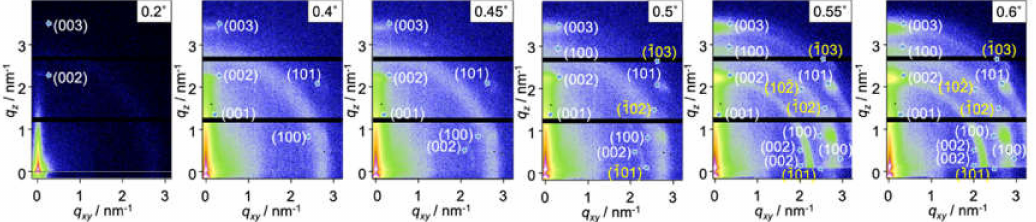
Figure 6. GIWAXS patterns of a PAc12DPI thin film on a Si wafer acquired using tender X-ray beam with di ff erent incident angles from 0.2 to 0.6 ◦ . Reproduced with permission [29]. 2018, American Chemical